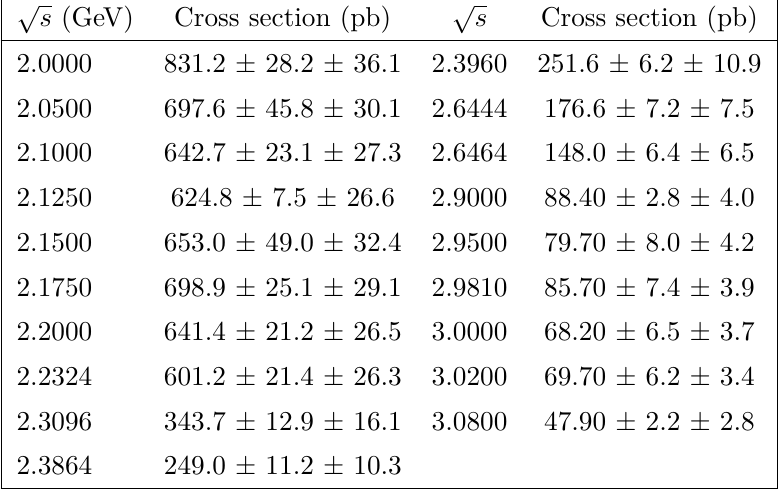
Table 8 . Cross sections of e + e − → ωππ , where the first and second uncertainties are statistical and systematic, respectively.